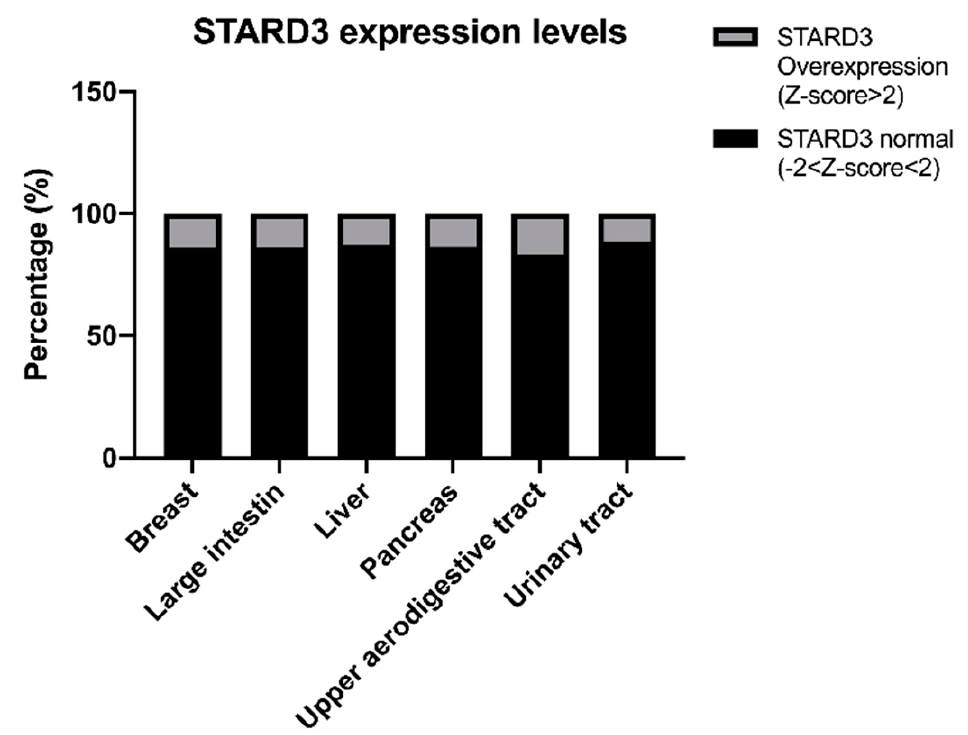
Figure 5. STARD3 expression levels in